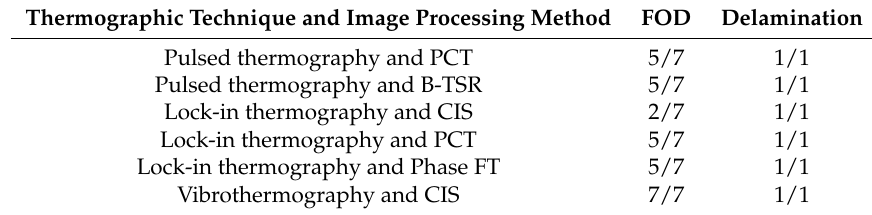
Table 4. Performance of thermographic